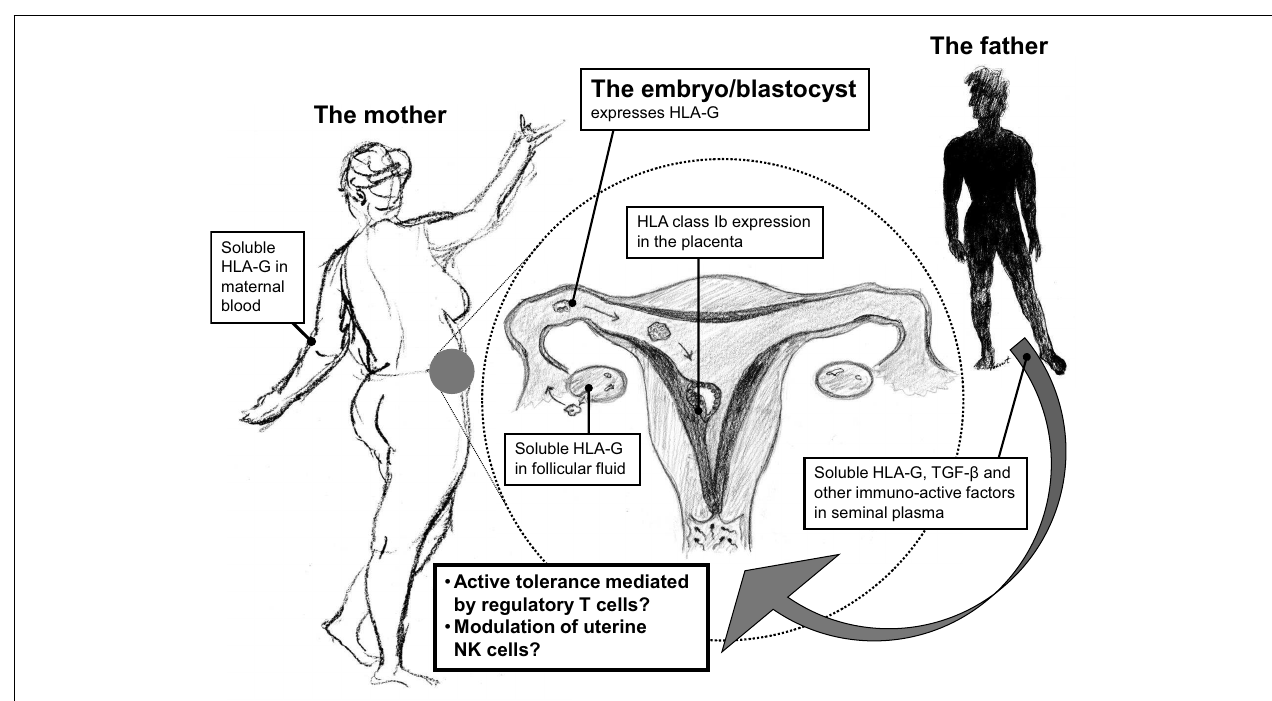
FIGURE 1 |An important and central role of HLA-G in reproduction may be depicted from its wide distribution within the reproductive cycle . HLA-G is expressed in maternal blood, in follicular fluid, and in seminal plasma prior to implantation, and after fertilization in the blastocyst/embryo and in the